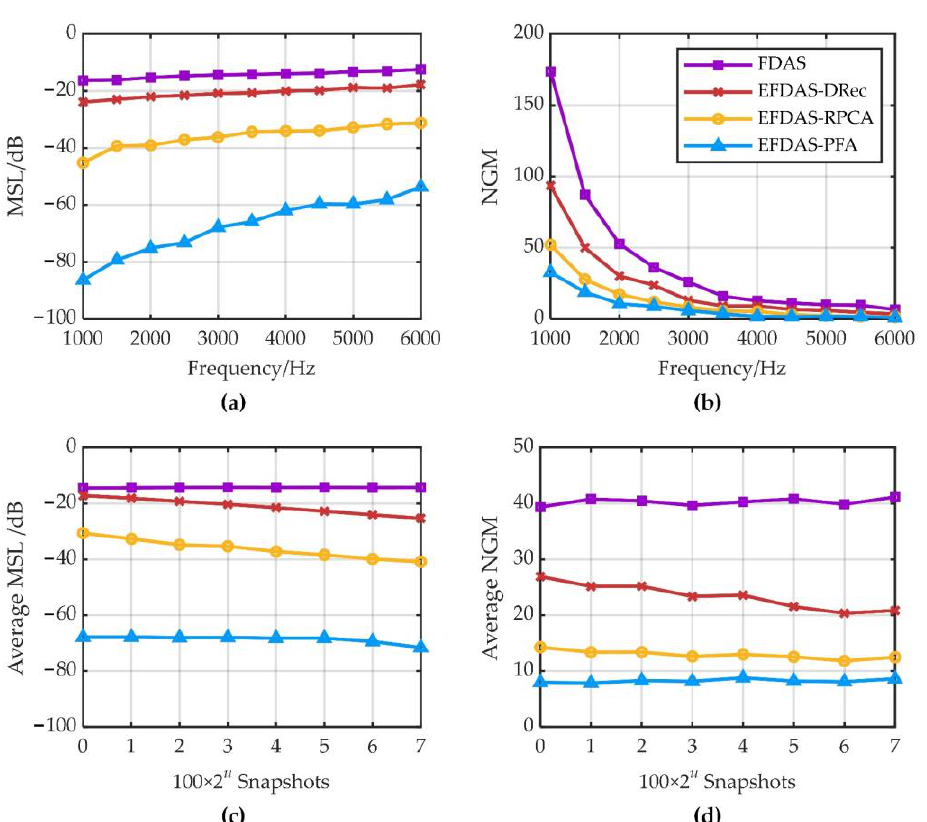
Figure 7. MSL and NGM of FDAS and EFDAS at SNR = 0 dB: ( a , b ) MSL and NGM under different frequencies; ( c , d ) Average MSL and NGM under different numbers of snapshots.